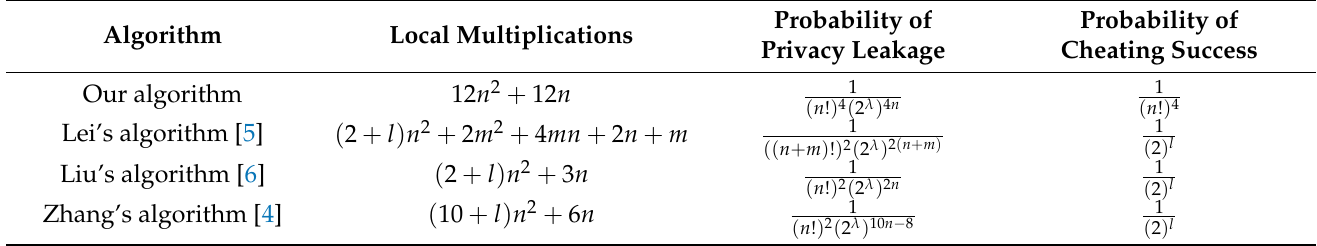
Table 1. Efficiency and Security comparative assessment.